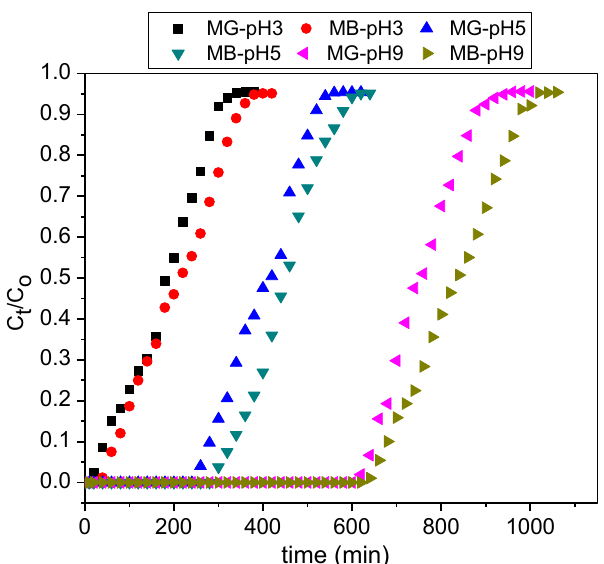
Figure 6. Breakthrough curves for adsorption of MG and MB in the binary system at varied solution pH ( 𝐶 0 : 50 mg/L; 𝑍 : 6 cm; 𝑄 : 3.0 mL/min). The T-PAA breakthrough bed capacity was minimum at pH 3 (MG: 5.4 mg/g; MB: 6.0 mg/g) and maximum at pH 9 (MG: 22.8 mg/g; MB: 24.9 mg/g) as reported in Table 4. This is due to the fact that